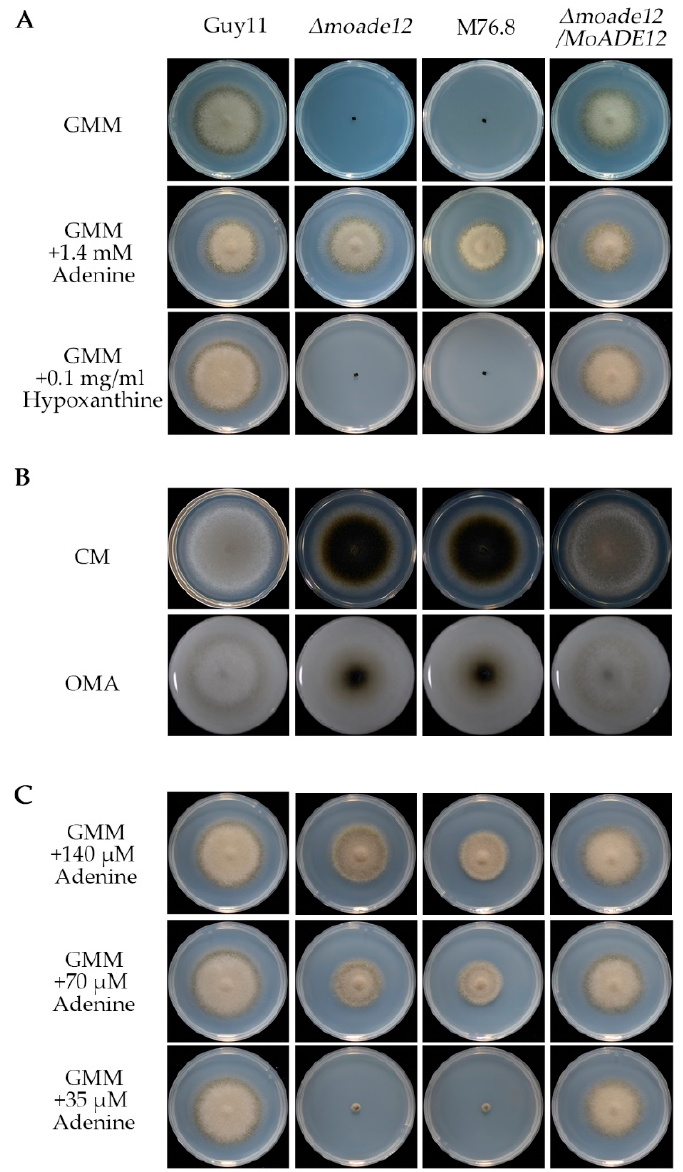
Figure 1. Deletion of the MoADE12 gene in M. oryzae resulted in adenine autotrophy, and reduced aerial hyphae growth on nutrient-rich media. ( A ) The ∆ moade12 mutant was grown on GMM plates (6-centimeter diameter) supplemented with adenine or hypoxanthine at the indicated concentrations for six days. ( B ) Colony morphology was examined on the CM and OMA plates (9-centimeter diameter) for nine days. ( C ) The ∆ moade12 mutant was grown on GMM plates (6-centimeter diameter) supplemented with adenine at the indicated concentrations for six days.